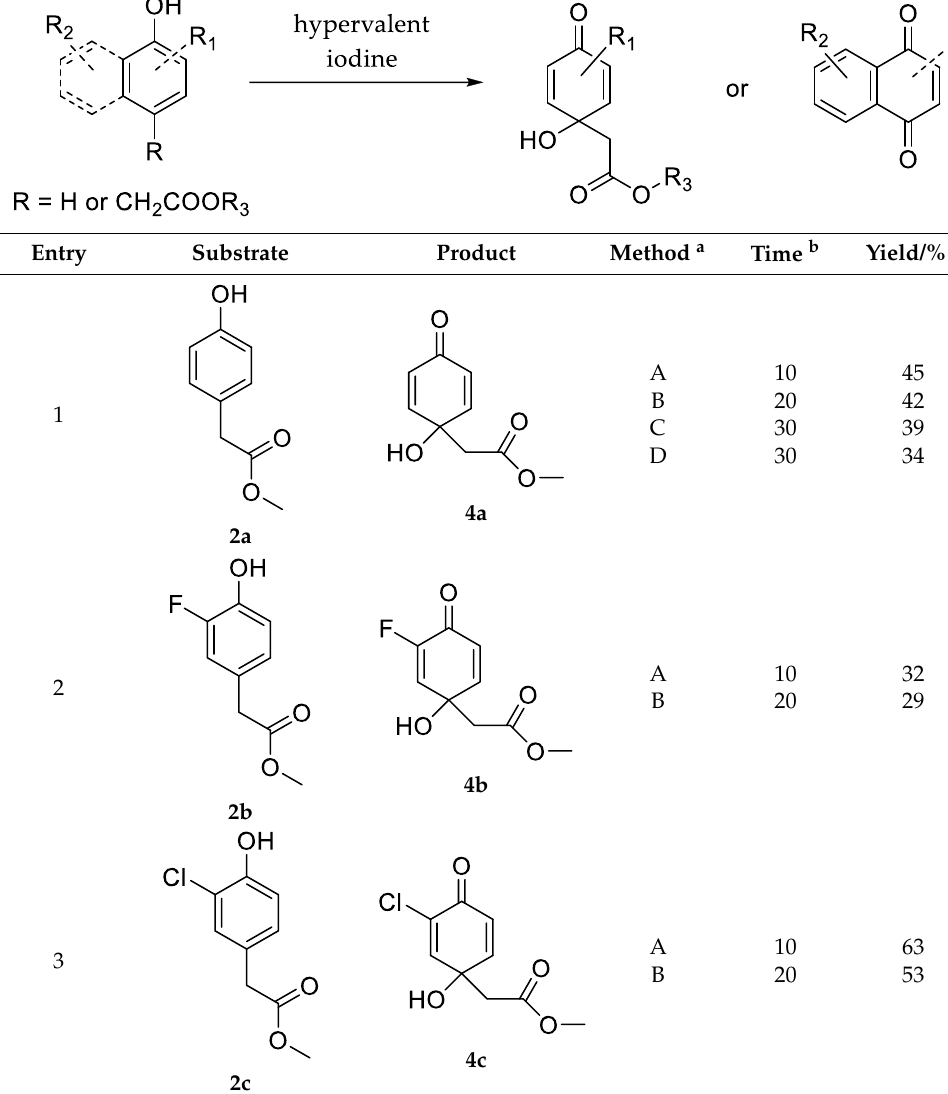
Table 1. Oxidation of phenols ( 2a – l ) and naphthols ( 3a – e ) in aqueous CH 3 CN using PIDA, PIFA and the µ -oxo dimer 1 .